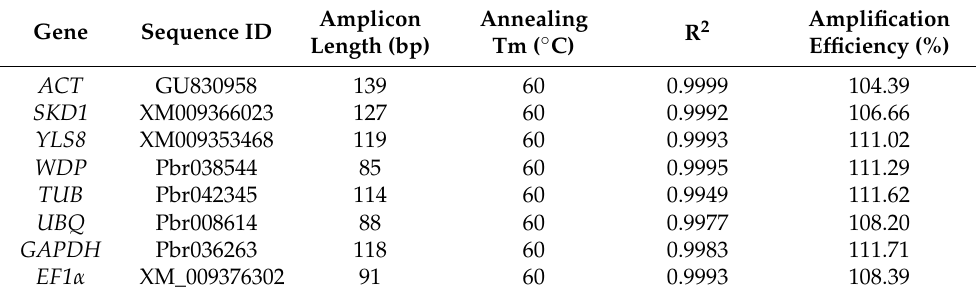
Table 1. List of genes and the optimized qPCR results for eight candidate reference